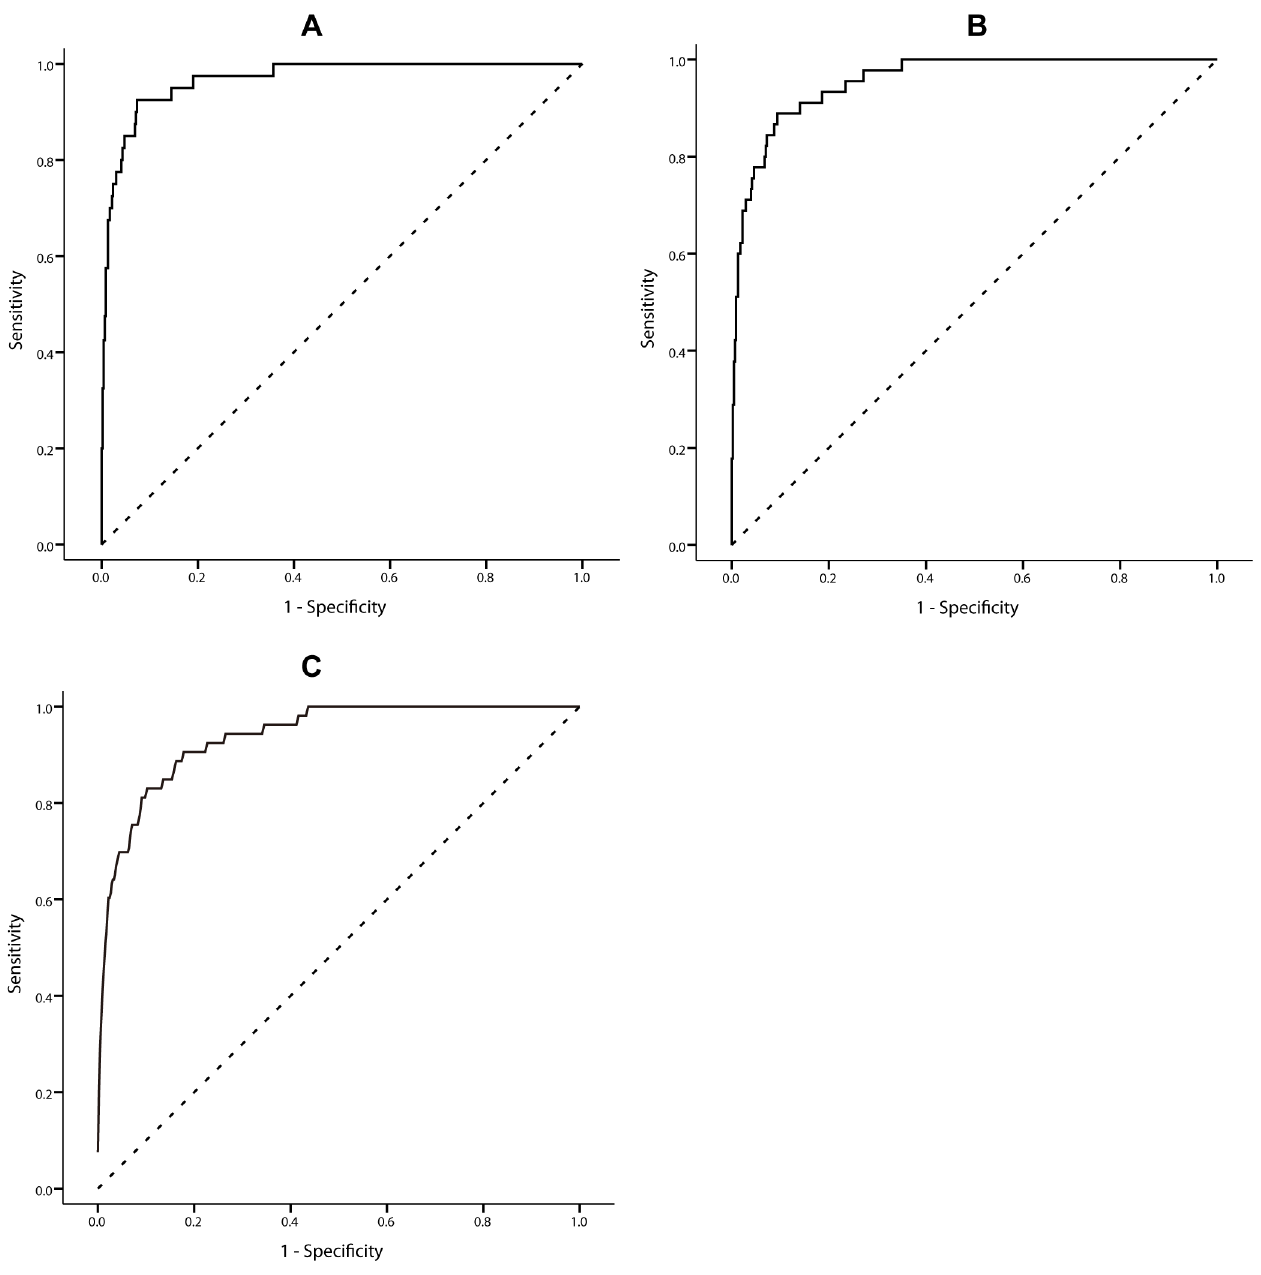
Fig 5. ROC curves for forecasting dengue epidemics in Zhongshan at a threshold of (A) 3 cases in a week, (B) 2 cases in a week and (C) 1 case in a week. To validate the robustness of our model and avoid overfitting, a k-fold cross-validation with a k value of 10 was applied. ROC curves were plotted again for each model in this section (S1 File), with average 0.938, 0.956 and 0.967 AUC at a forecasting threshold of 1, 2 and 3 cases per week, respectively. In the out-of-sample prediction (detailed results in S1 File), the sensitivity of our model remained as high as 78.83% and specificity 92.48% when we intend to forecast outbreaks involving more than 3 cases in a week in Zhongshan. Similarly, when we intend to forecast outbreaks with a smaller threshold, i.e., 1 case per week, our model had a sensitivity of 85.16% and specificity of 87.25% and at 2 cases per week, the sensitivity was 91.17% and specificity 84.00%. Such results meant that our model was rather robust and